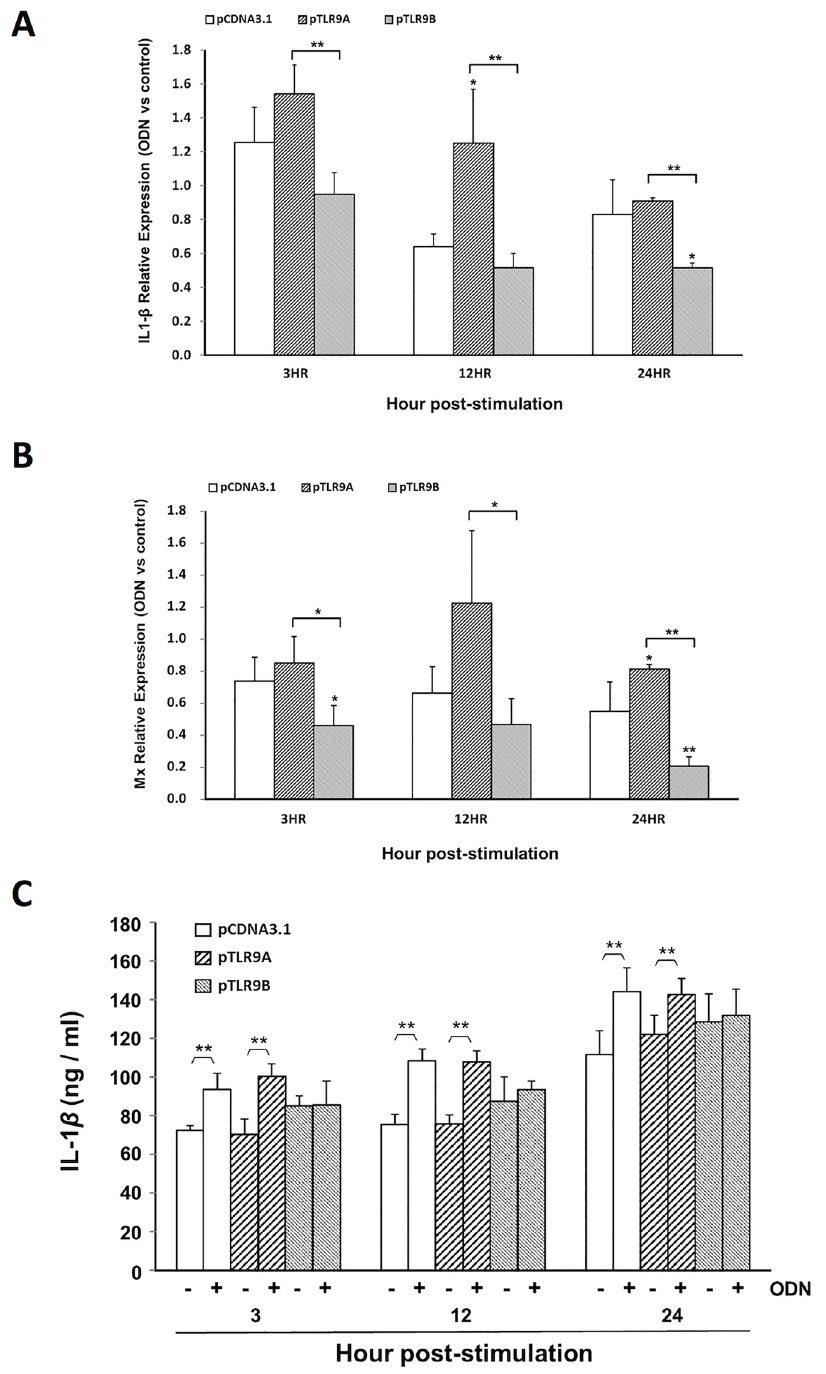
Fig 3. The inhibitory effect of gTLR9B on TLR9 signaling. GK cells were co-transfected with plasmids capable of expressing either gTLR9A (pcDNA3.1-9A) or gTLR9B (pcDNA3.1-9B) along with plasmid pRL-TK encoding Renilla luciferase as a transfection control using Lipofectamine 2000 (Invitrogen). A , Total RNA was harvested to measure the expression of genes downstream of TLR9 signaling. B , An ELISA assay was performed to determine IL-1 β protein expression. All values were normalized to Renilla mRNA expression. * 0.01 < p < 0.05, ** p < 0.01, Student ’ s t